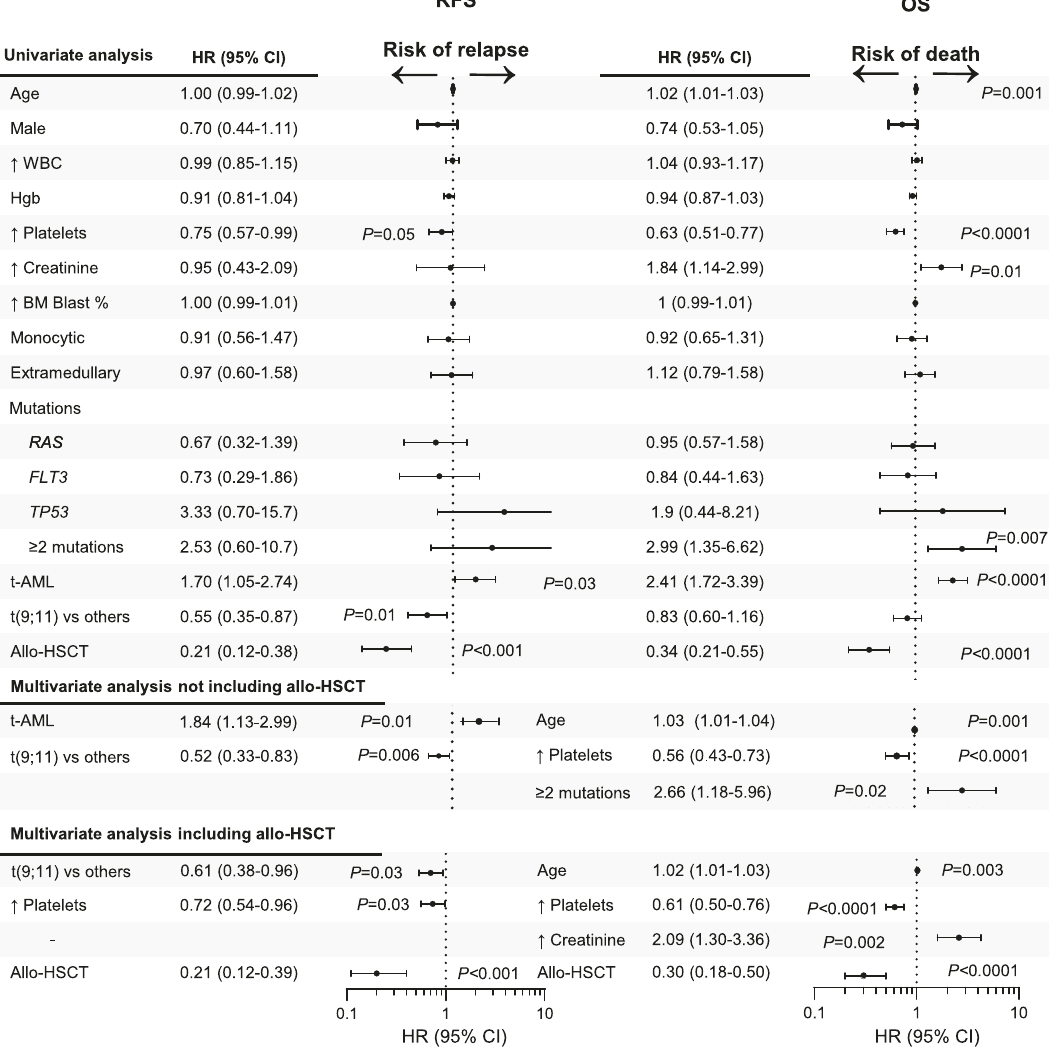
Fig. 5 Univariate and multivariate analyses of factors predicting risks of relapse or death in newly diagnosed KMT2Ar AML. Variables with P ≤ 0.05 were included in the multivariate analysis. RFS relapse-free survival, OS overall survival, HR hazard ratio, WBC white blood cell count, Hgb hemoglobin, BM bone marrow, t-AML therapy-related AML, allo-HSCT allogeneic hematopoietic stem cell